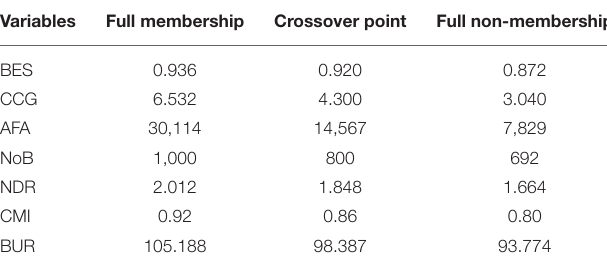
TABLE 3 | Three qualitative anchors of each variable.